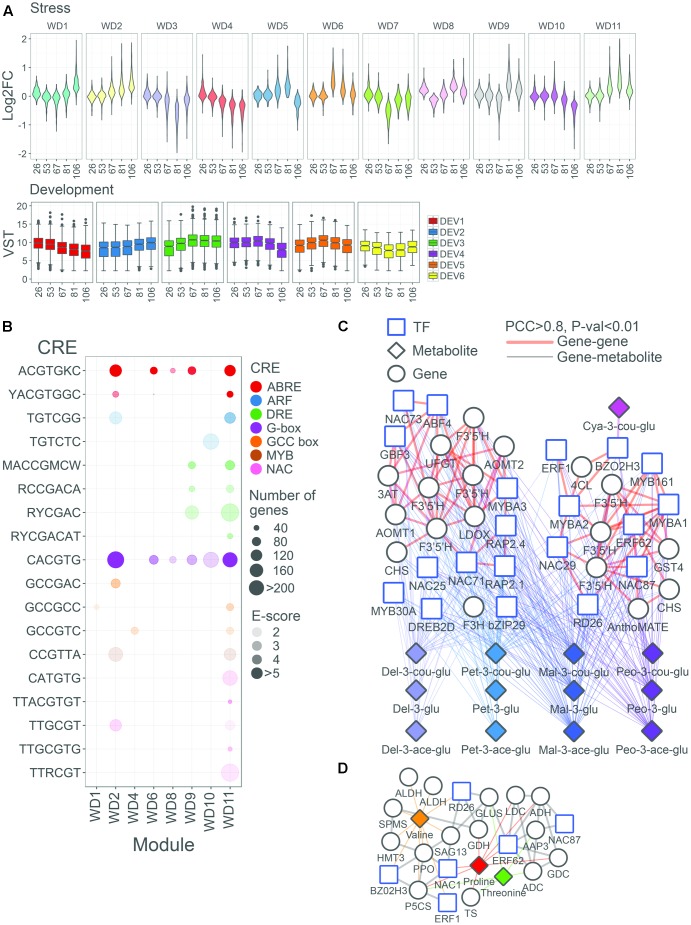
Functional overview of biological modules modulated by water deficit in the grape berry. (A) Violin plots represent the distribution of log2FC (WD/CT) of all DE genes in stress (WD) co-response gene modules. Box plots represent the distribution of variance stabilized transformed expression values of DE genes in development (DEV) co-regulated gene modules. (B) Overview of selected enriched cis-regulatory elements (CREs) in stress co-response genes modules. Colors of circles representative the TF family that recognize a designated CRE. Sizes or circles represent the number of genes containing a designated CRE in their promoter region. Opacity of circles (in color) represent the enrichment score, –log10(FDR), of CREs. Only enriched CREs (FDR < 0.01) in designated modules are depicted. Network representation of WD2 and WD11 modules, having ripening-associated expression patterns (DEV2/3/5), centered on significantly correlated TF and/or structural genes with (C) anthocyanin (pink, lavender blue, cyan, blue, and purple), and (D) amino acid compounds (orange, red, and green). Structural genes, TF, and metabolites are represented by circle, square, and triangle nodes, respectively. Thick edges in light red and gray edges represent associations between genes/TFs (PCC > 0.8; P < 0.01) for (C,D), respectively. Gene-metabolite (PCC > 0.8; P < 0.01) are depicted in thinner edges and the different colors denote different categories, as reported in (C,D).